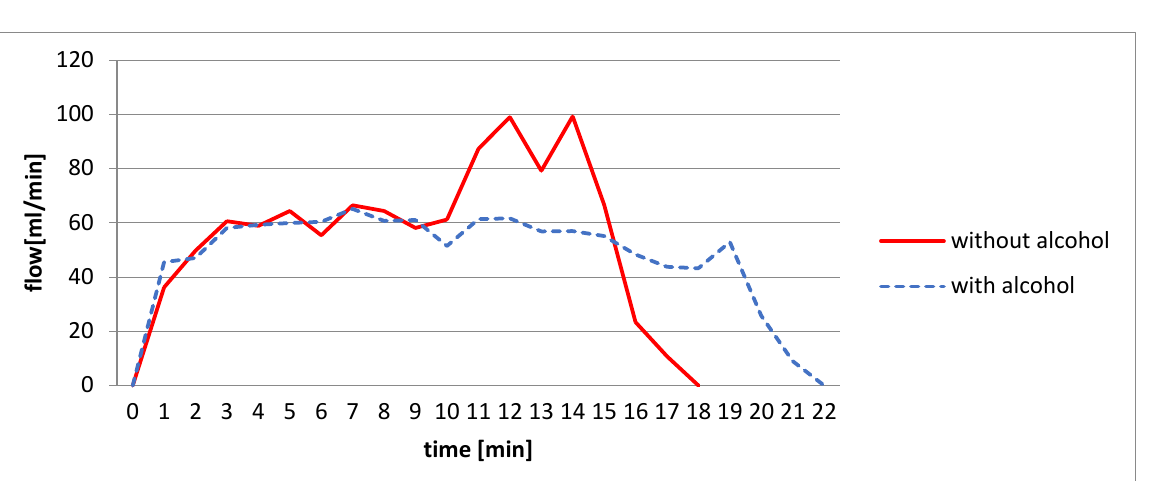
from a 7.5 M sheet, with and without isopropyl alcohol at initially 60 ◦ 2 , t )